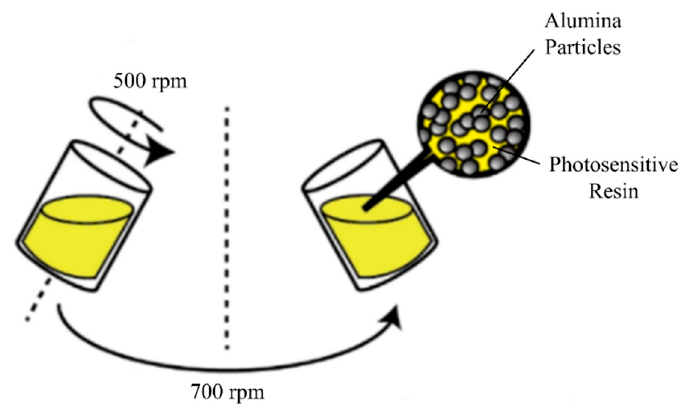
Figure 2. Schematic diagram of paste mixing by simultaneous rotation and revolution.